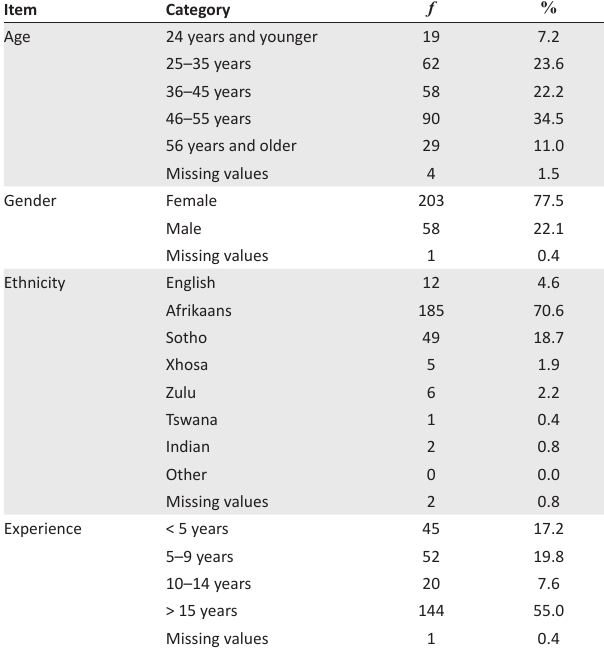
TABLE 1: Characteristics of the participants ( n =